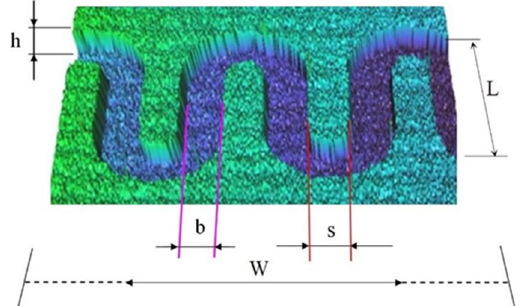
Figure 11. Micro-channel parameters considered for the analytical model.